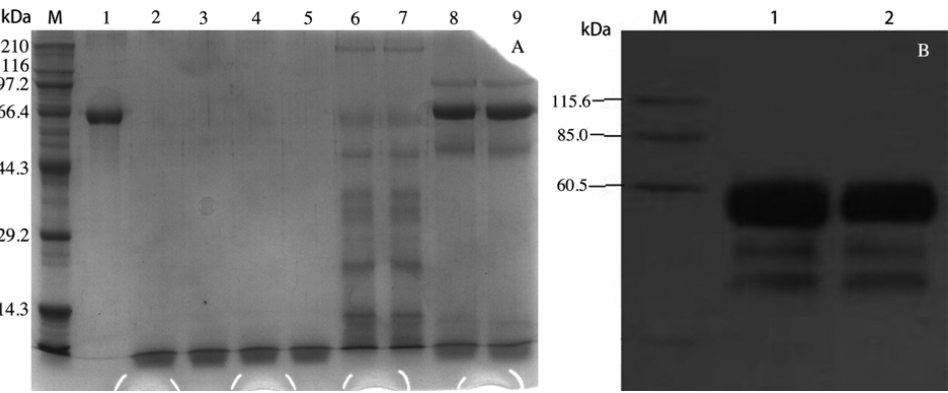
Figure 1. SDS-PAGE analysis of rVAA-I generated from Pichia pastoris ( A ). Lane M: Markers lanes, Lane 1: purified VAA-I, Lane 2–5: BMMY culture, Lane 6–7: supernantants of transformed yeast with blank pPICZ  -A, Lane 8–9 supernantants of transformed yeast; Western Blotting analysis of rVAA-I generated from Pichia pastoris ( B ).